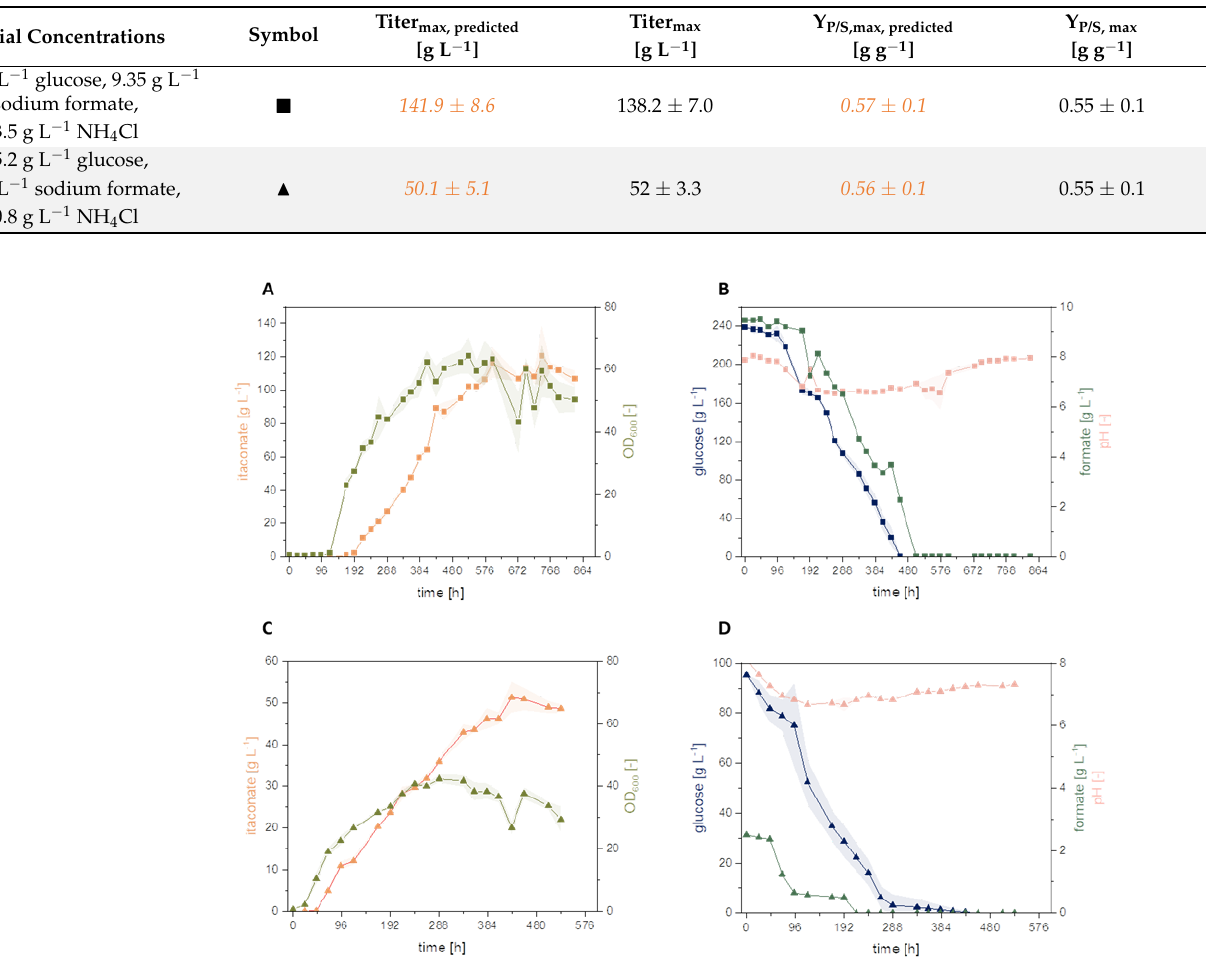
Figure 6. Model validation experiment. Two validation conditions were tested in shake flask culti- vation using U. cynodontis ∆ fuz7 ∆ cyp3 P etef mttA ↑ P ria1 . ( A , B ) display cultivation using 238.8 g L − 1 glucose, 9.35 g L − 1 sodium formate, and 3.5 g L − 1 NH 4 Cl ( ■ ) while ( C , D ) show cultivation using 95.2 g L − 1 glucose, 2.5 g L − 1 sodium formate, and 0.8 g L − 1 NH 4 Cl ( ▲ ). Color code shows OD 600 (light green), itaconate production (orange), glucose consumption (blue), sodium formate consumption (dark green), pH (light pink). Cultivations were carried out in shake flasks following (Section 2.1). MTM medium with 66 g L − 1 CaCO 3 was used. Error bars depict the standard deviation of the mean ( n = 3).